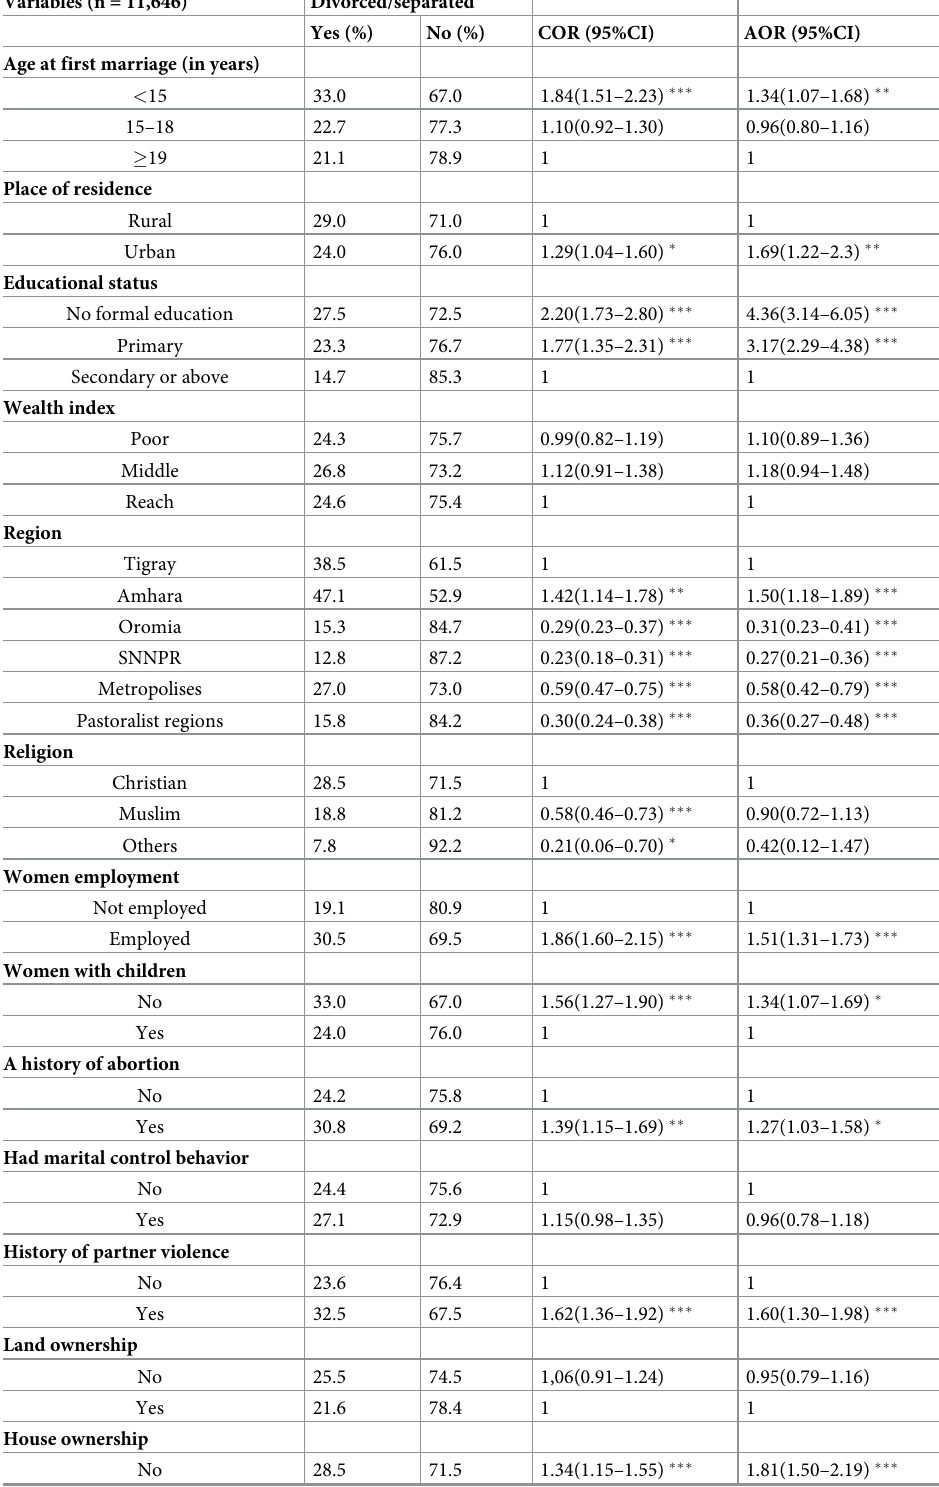
Table 2. Factor associated with divorce among ever-married women in Ethiopia, 2016